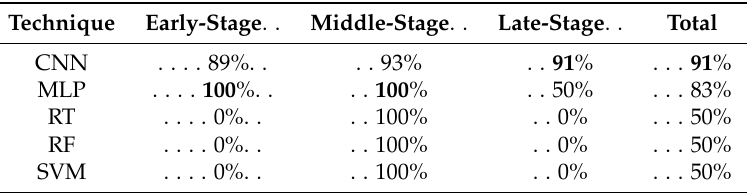
Table 1. Classification results the given dataset. CNN stands for Convolutonal Neural Network, MLP stands for Multi-Layer Perceptron, RT for Random Trees, RF for Random Forest, and SVM for Support-Vector Machines. The best results are highlighted in